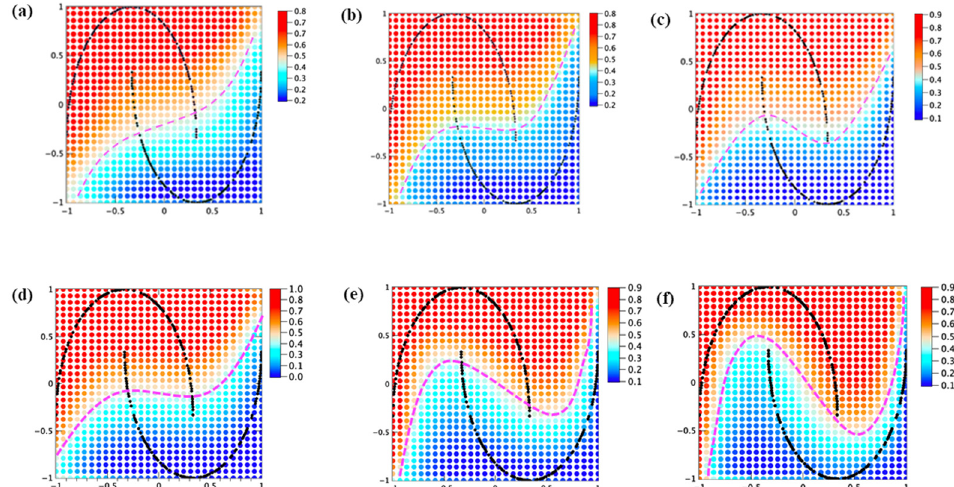
Figure 7. Improvement of quantum learning efficiency using the 200 data make_moon dataset. (i) Effect of quantum circuit depth on the classification accuracy. Training data set of label ‘0’ and blue for label ‘1’ are shown in dotted black line, and pink line corresponds to the median boundary of the continuous probability. ( a ) Four layers of the quantum circuit with 4 qubits. ( b ) Seven layers of the quantum circuit with 4 qubits. ( c ) Ten layers of the quantum circuit with 4 qubits. (ii) Effect of scaling parameter γ on the classification accuracy. ( d ) γ = 1. ( e ) γ = 3. ( f ) γ = 5 .